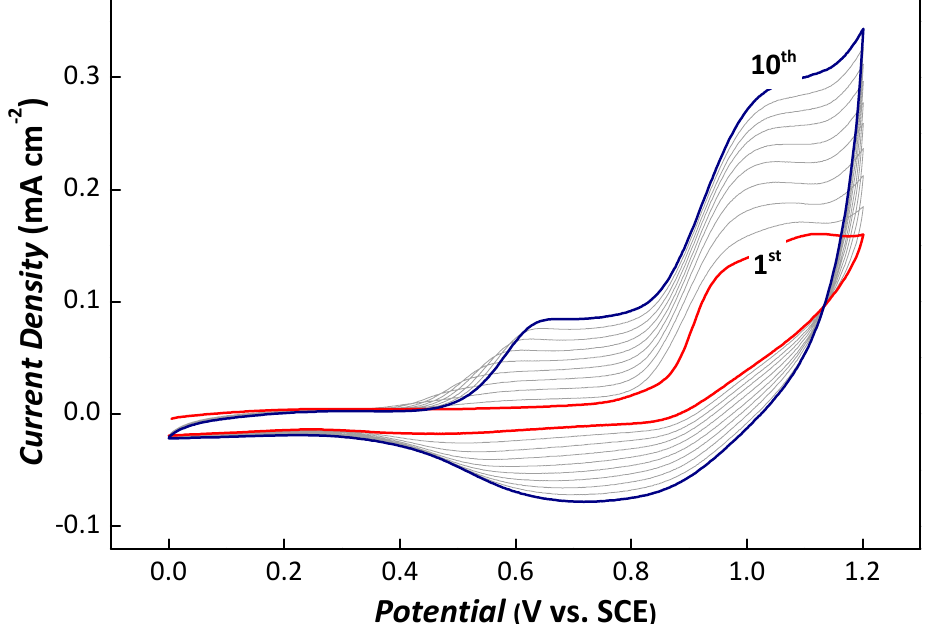
Figure 1. Cyclic voltammograms for the electropolymerization of the [Pd(salen)] complex (1.0 mmol L − 1 ) on the platinum electrode in acetonitrile containing 0.10 mol L − 1 tetrabutylam- monium hexafluorophosphate at a scan rate of 100 mV s − 1